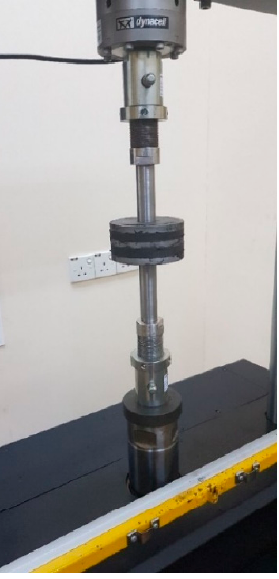
Figure 5. Testing on the product sample using Dynacell machine.